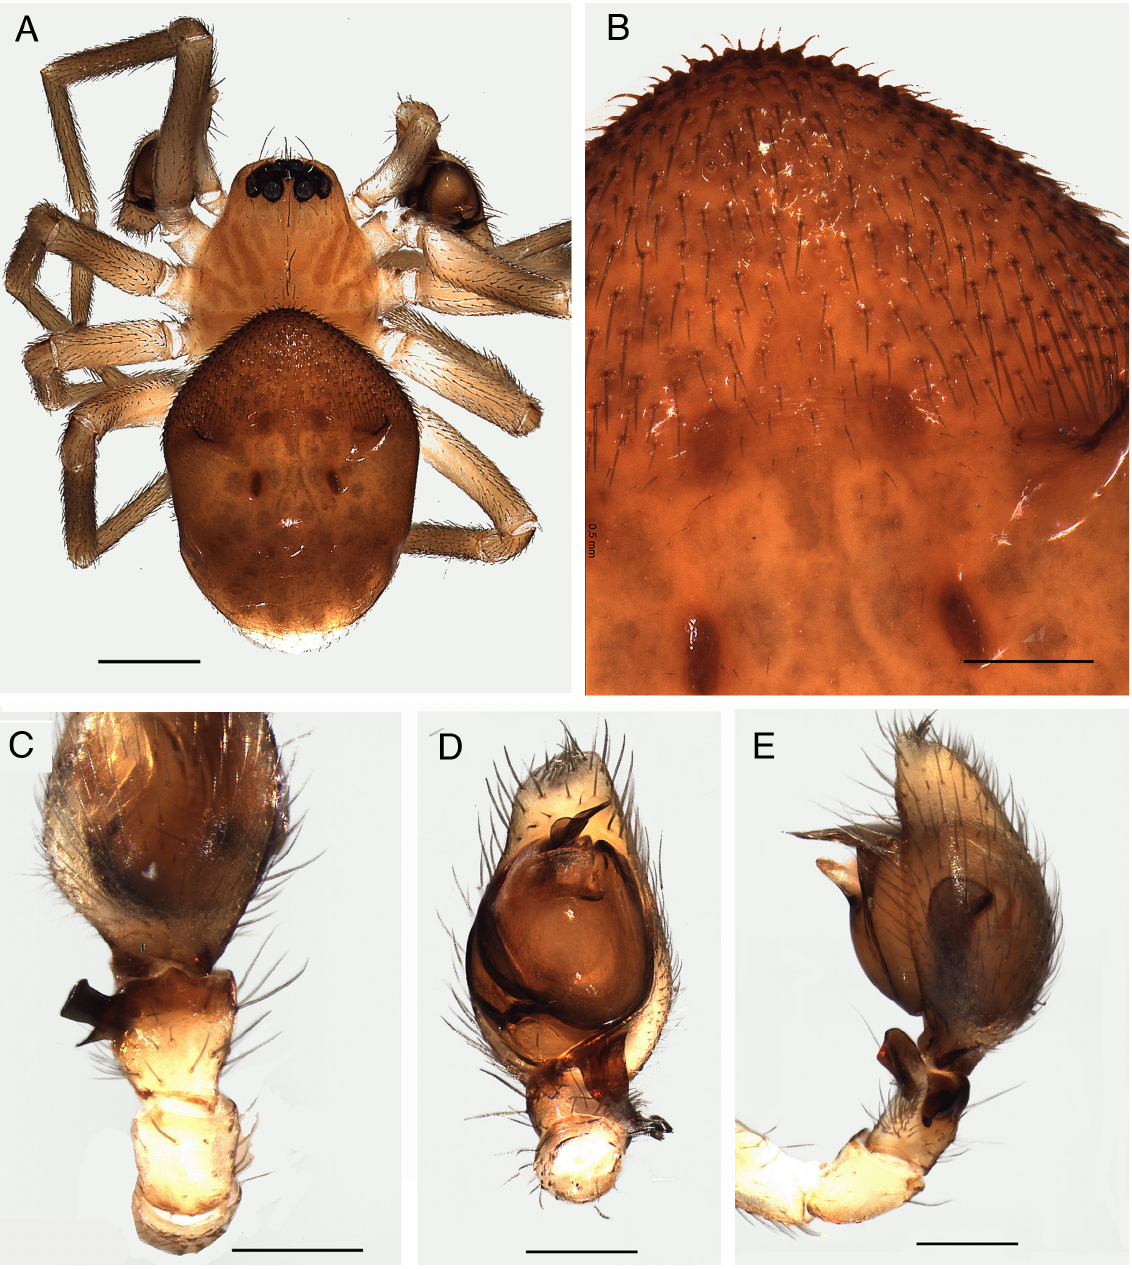
Fig. 11. Chumma tsitsikamma sp. nov., holotype, ♂. A . Habitus, dorsal view. B . Anterior part of abdomen, dorsal view. C . Palp, dorsal view. D . As preceding, ventral view. E . As preceding, retrolateral view. Scale bars: A–B = 0.5 mm; C–F = 0.2